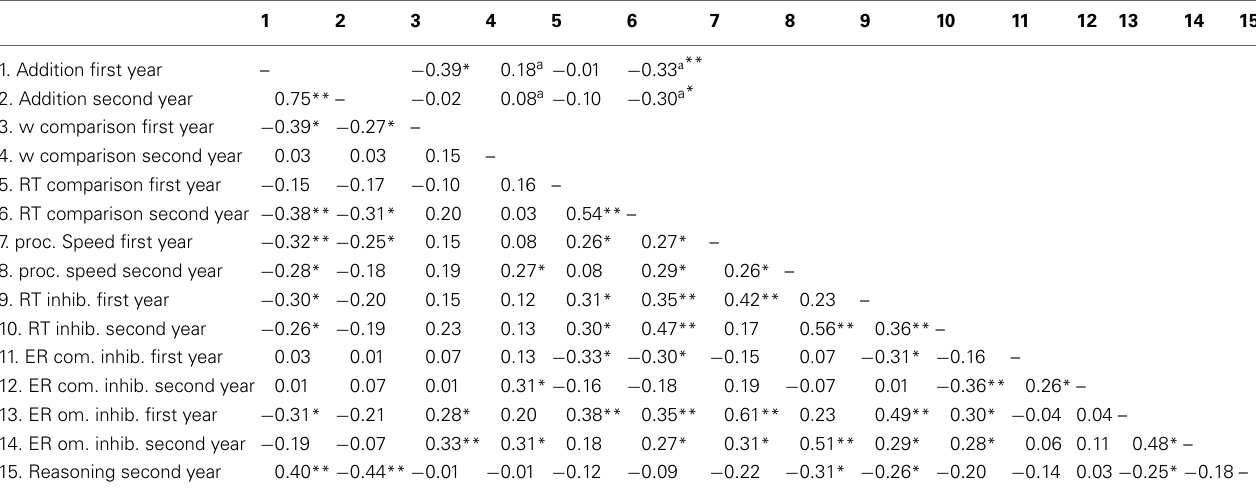
Table 2 | Bivariate (below the diagonal) correlation coefficients for all observed variables and partial (above the diagonal) correlation coefficients between individual markers of the ANS (internal Weber fractions [w comparison] and mean reaction times [RT comparison] in the non-symbolic numerical comparison task) and addition performance within and across the respective years (processing speed [proc. speed]; reaction times, omission, and commission errors in the inhibitory control task [RT inhib., ER om. inhib., ER com. inhib.]).